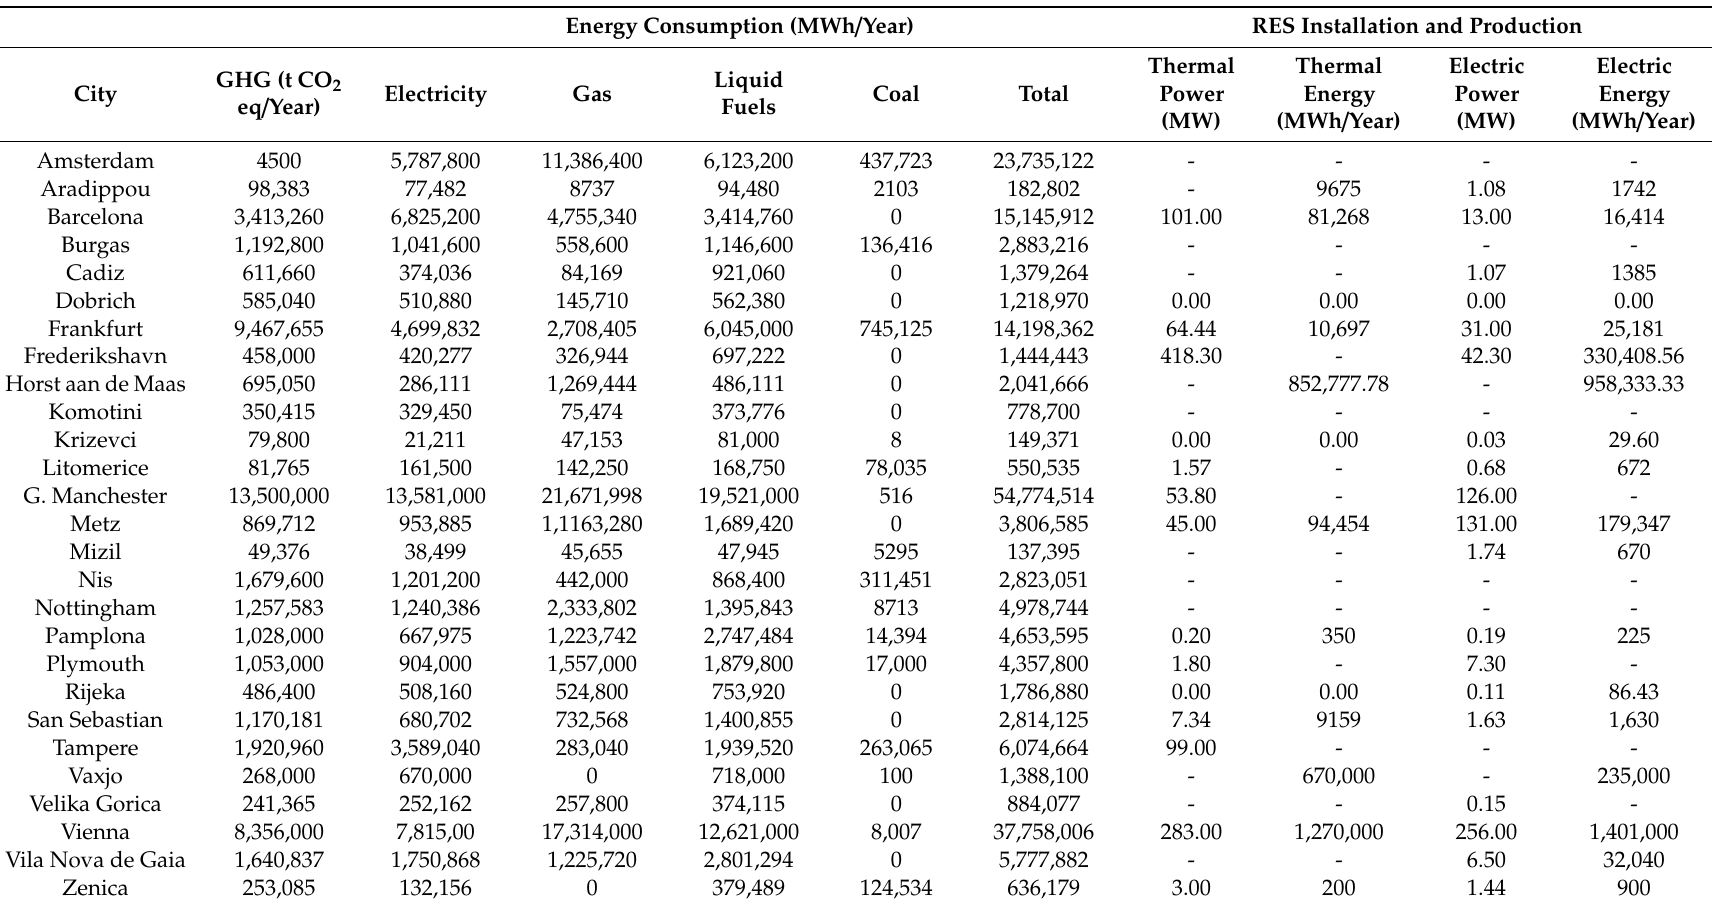
Table A2. GHG emission, energy consumption and RES installation and production data of all 27 municipalities, after the standardisation of the results. Energy Consumption (MWh / Year) RES Installation and Production Thermal Thermal Electric GHG (t CO 2 Liquid City Electricity Gas Coal Total Energy eq / Year) Fuels